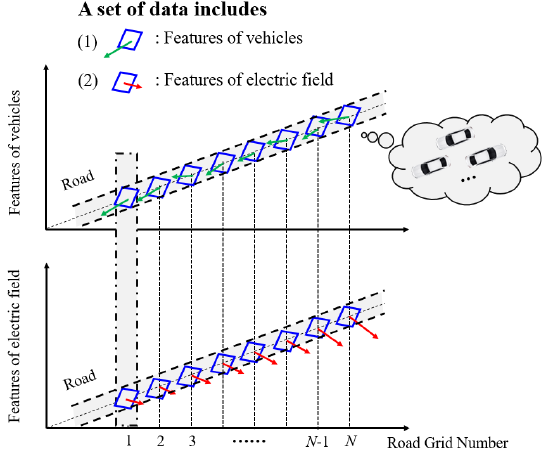
Figure 11. The data collection method used in the present study of the correlation between the urban commuting electric field and the urban road-traffic commuting.